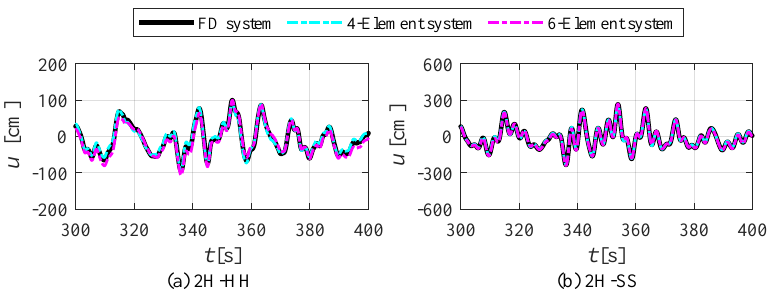
Figure 23. Comparison of the time-history analysis of the across-wind displacement (300–400 s).